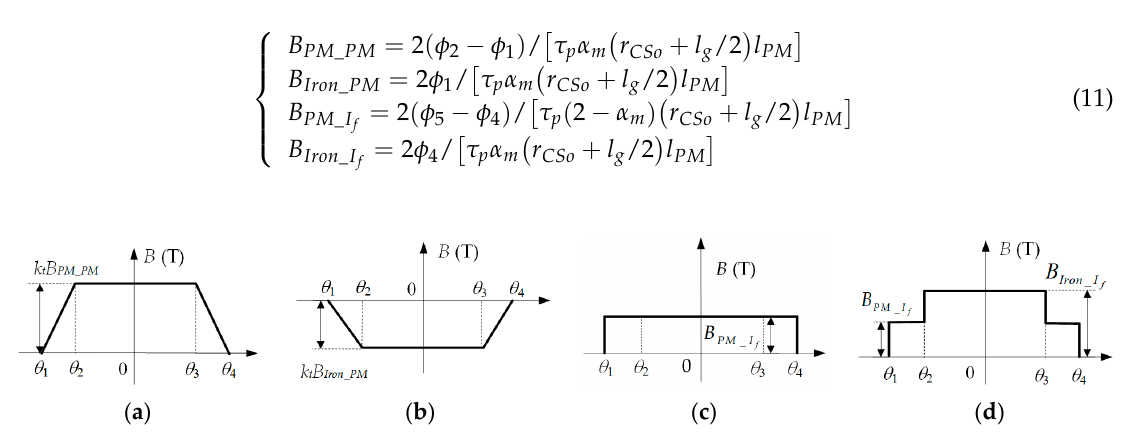
Figure 4. The model of air-gap flux density. ( a ) B PM excited by PMs. ( b ) B Iron excited by PMs. ( c ) B PM excited by I f . ( d ) B Iron excited by I f .